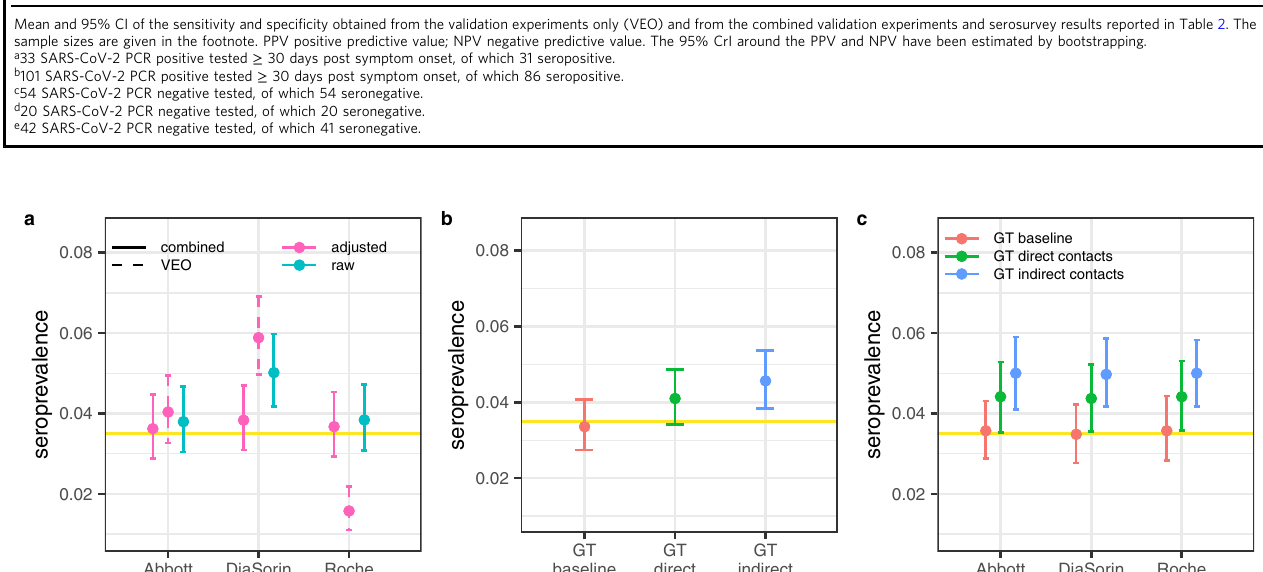
Fig. 2 Seroprevalence estimates in Vo ’ in May 2020. a Assay-speci fi c seroprevalence estimates: the raw seroprevalence estimates (cyan) represent the proportion of subjects testing positive; adjusted seroprevalence estimates (pink) are the raw seroprevalence estimates adjusted for the estimated assay- speci fi c sensitivity and speci fi city (Table 3) from the validation experiments only (VEO) (dashed) and the results of the combined analysis of validation experiments and serosurvey results (solid); b Estimated seroprevalence in May 2020 using the three ground truth de fi nitions: baseline (red), direct contacts (green) and indirect contacts (blue). c Assay-speci fi c seroprevalence estimates adjusted for the sensitivity and speci fi city of three ground truth (GT) de fi nitions (Supplementary Table 3). In each panel, the horizontal solid yellow line represents the mean seroprevalence estimate obtained from the multinomial likelihood model; the horizontal yellow shading represents the 95% CrI. Points represent the mean, the error bar identi fi es the 95% CrI. The results were obtained by sampling n = 1,000 realisations from the posterior distribution of the parameters.